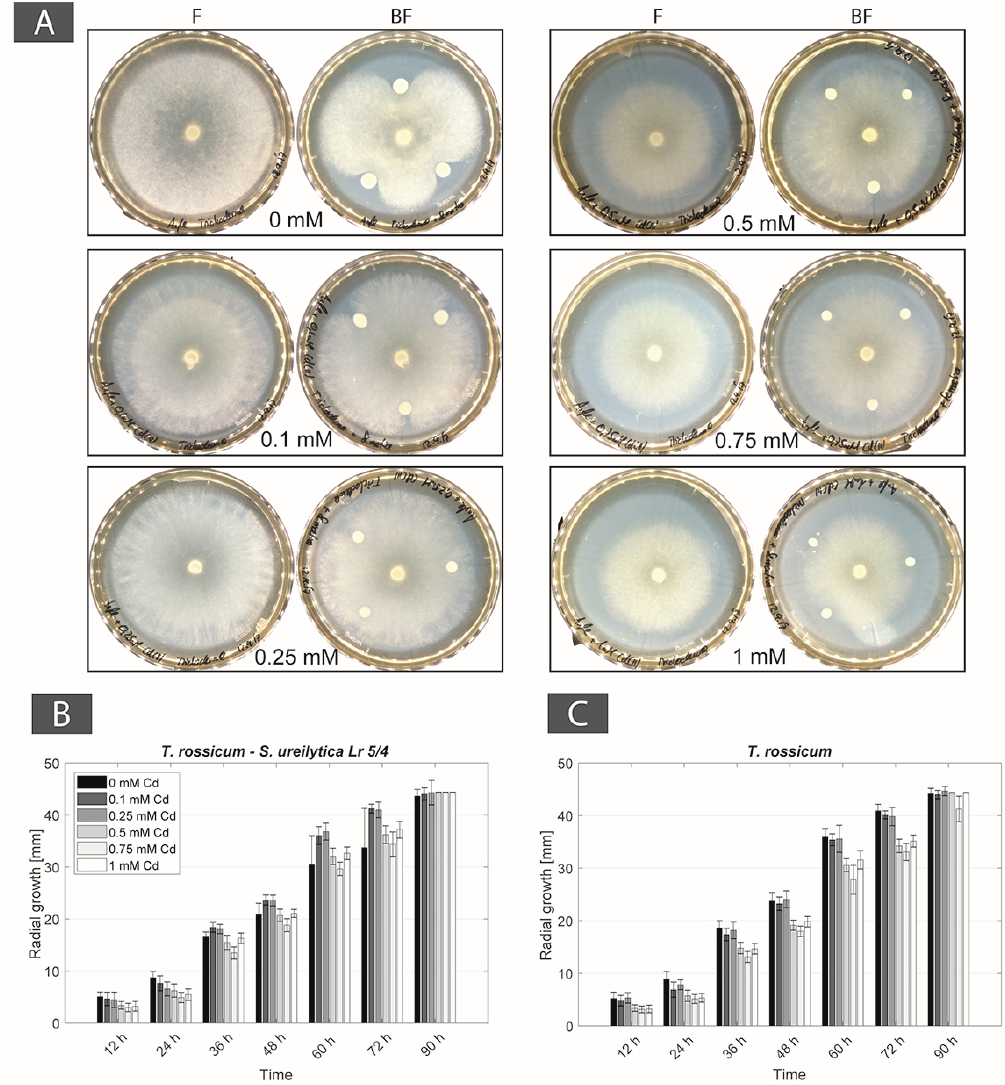
Figure A2. ( A ) Photographs of mono-cultures of Trichoderma rossicum (F panels) and co-cultures of T. rossicum + Serratia ureilytica Lr 5/4 (BF panels) in Angle medium (0 mM Cd) and Cd-containing Angle medium (0.1, 0.25, 0.5, 0.75, and 1 mM Cd); ( B ) Radial mycelial growth of T. rossicum in co-culture with S. ureilytica Lr 5/4 in Angle medium (0 mM Cd) and Cd-containing Angle medium (0.5 and 1 mM Cd); ( C ) Radial mycelial growth of T. rossicum in mono-culture in Angle medium (0 mM Cd) and Cd-containing Angle medium (0.1, 0.25, 0.5, 0.75, and 1 mM Cd).